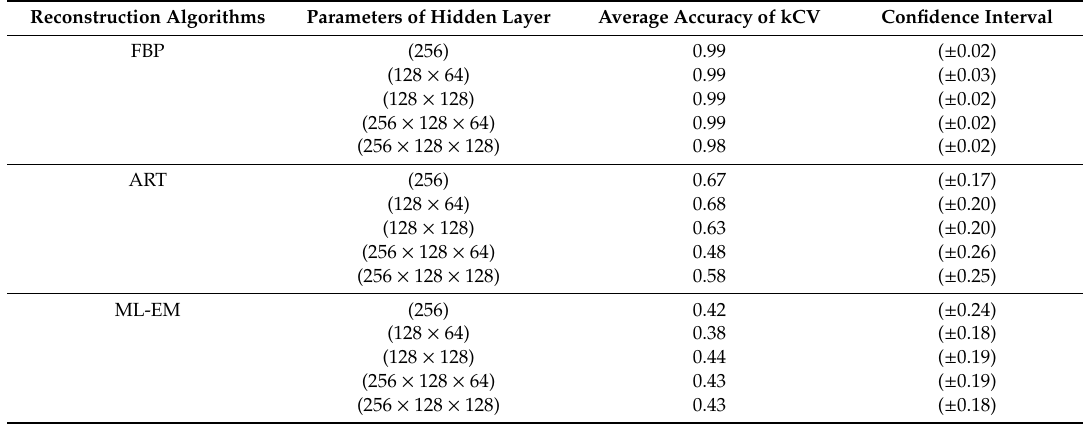
Table 5. Elementary evaluation results a ff ected by multiple parameters of hidden layer. Reconstruction Algorithms Parameters of Hidden Layer Average Accuracy of kCV Confidence